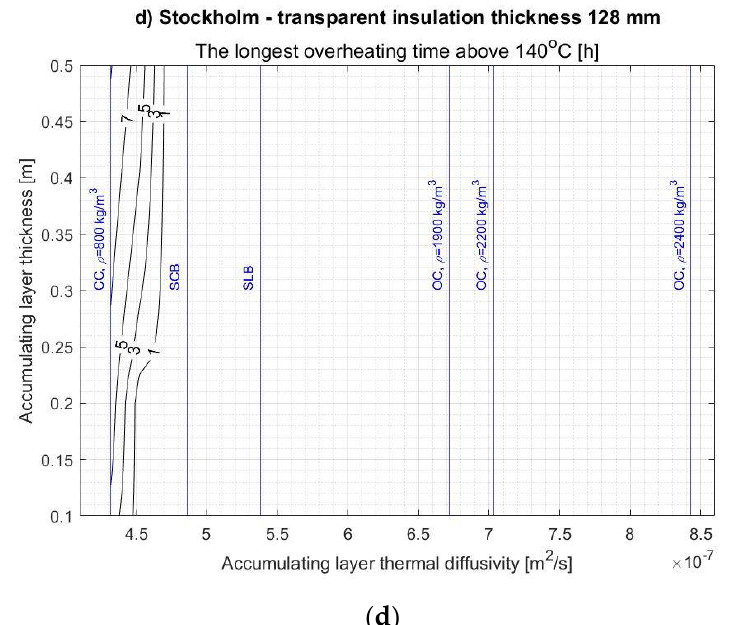
Figure A3. Contour graphs characterizing the SW basic parameters in a function of AL thermal diffusivity and thickness for the whole heating season: ( a ) the heat balance of the SW’s unit area, ( b ) the heating time, ( c ) the mean time lag of the maximum temperature on the absorber and SW’s internal surface during the day, ( d ) the longest overheating time above 140 °C in the TI. TI thickness: 128 mm. Location: Stockholm.